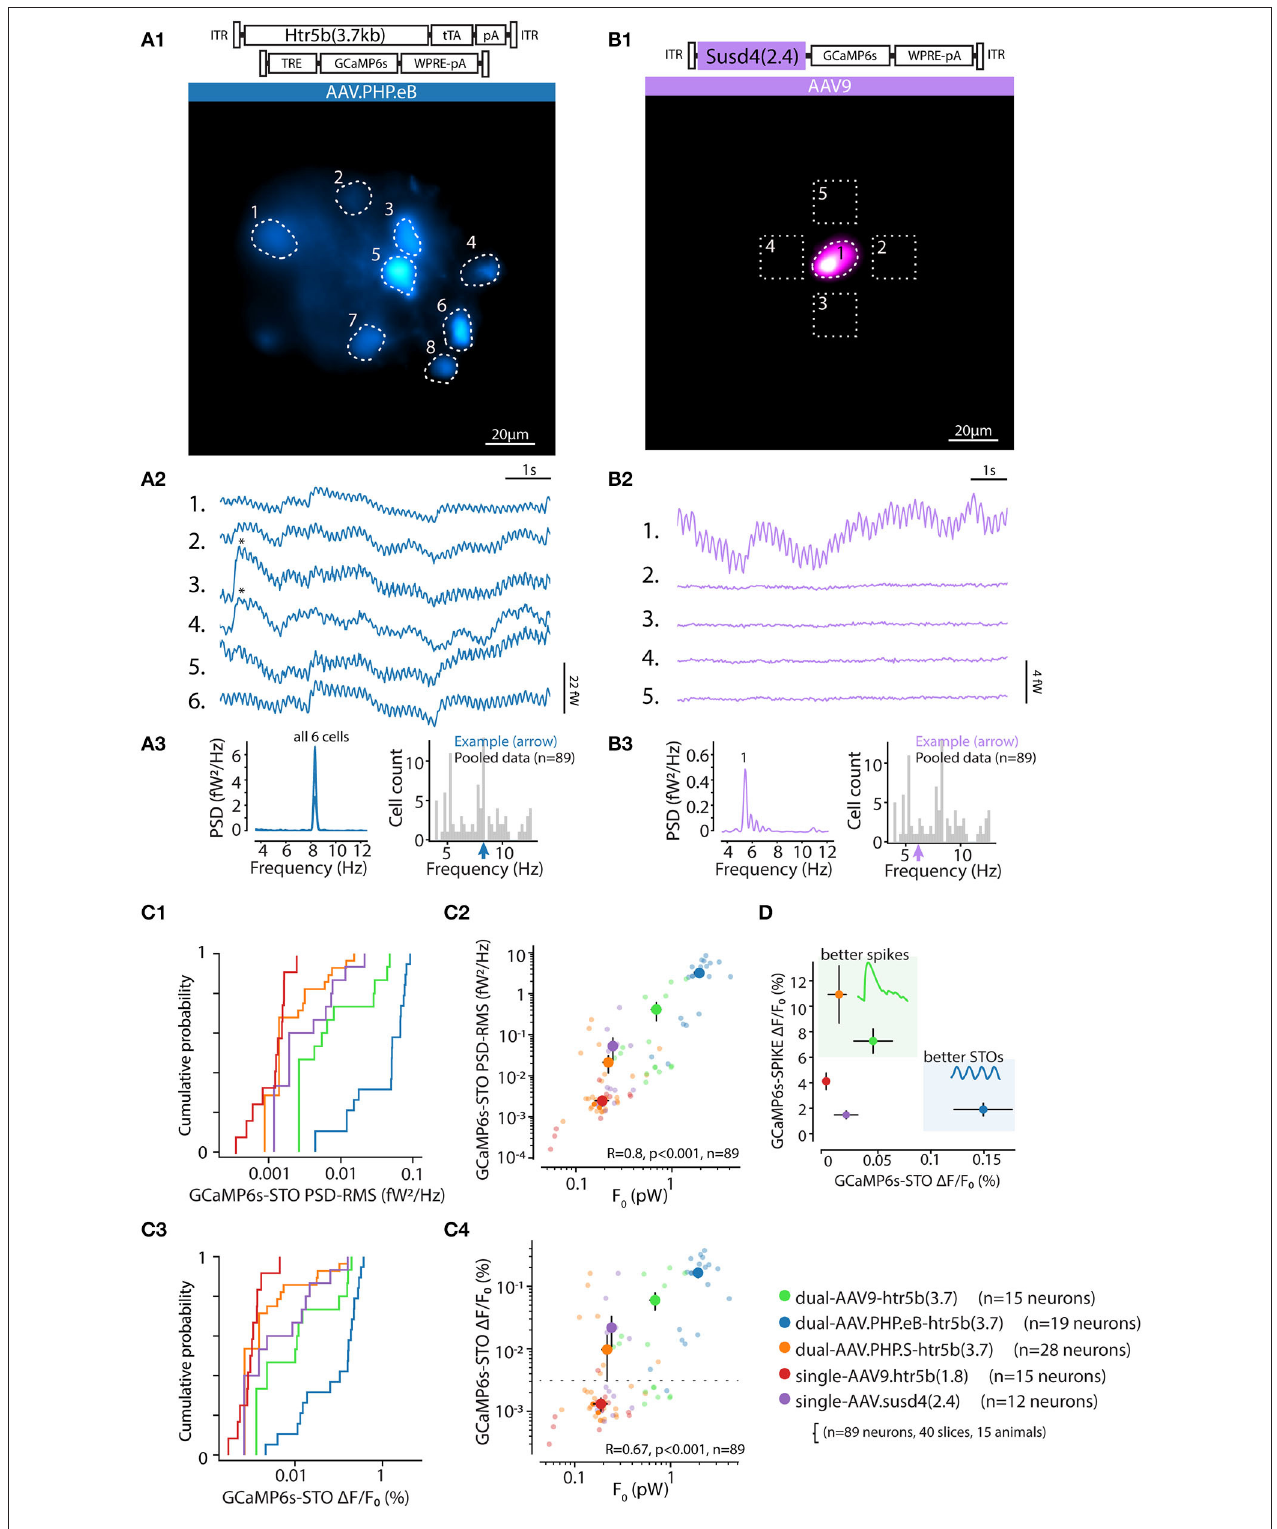
FIGURE 9 | In-vitro calcium imaging of IO subthreshold oscillations. (A,B) Example in vitro calcium imaging recordings from dense (A) and sparse (B) transfection, using the constructs as indicated above the panels. Identified IO neuron somata are indicated with dotted ROIs in time-series projection images in (A1,B1) ; note that the image brightness is adjusted for viewing and should not be considered as representative of the dynamic range during live imaging. The GCaMP6s traces